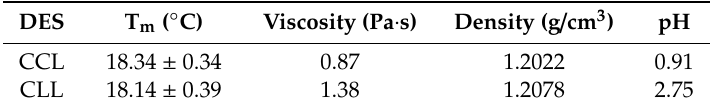
Table1. Generalphysicalparametersofnovelcholinelactate–lacticacid(CLL)andcholinechloride-lactic acid